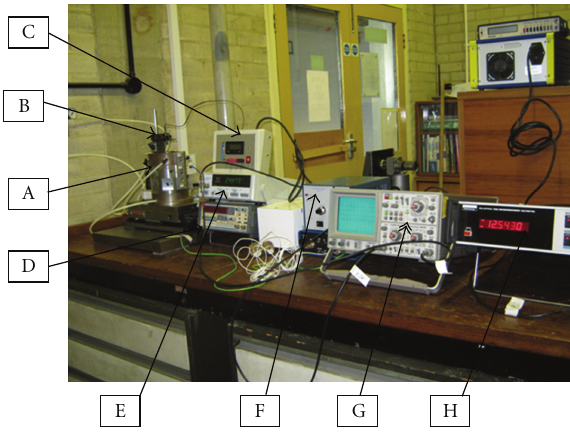
Figure 5: Overview of experimental test rig and apparatus: (A) Test Rig, (B) Speed Optical Sensor, (C) Speed Meter, (D) Displacement Probe Actuator, (E) Sine Wave Generator, (F) Piezoelectric Ampli- fier, (G) Oscilloscope, (H) Voltmeter.